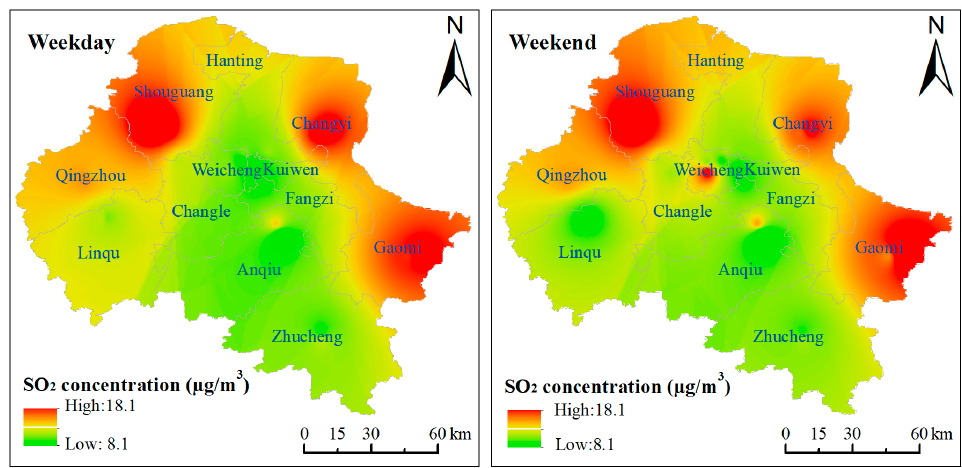
Figure 7. Comparison of the spatial distribution of SO 2 on weekdays and weekends in Weifang City in 2020.